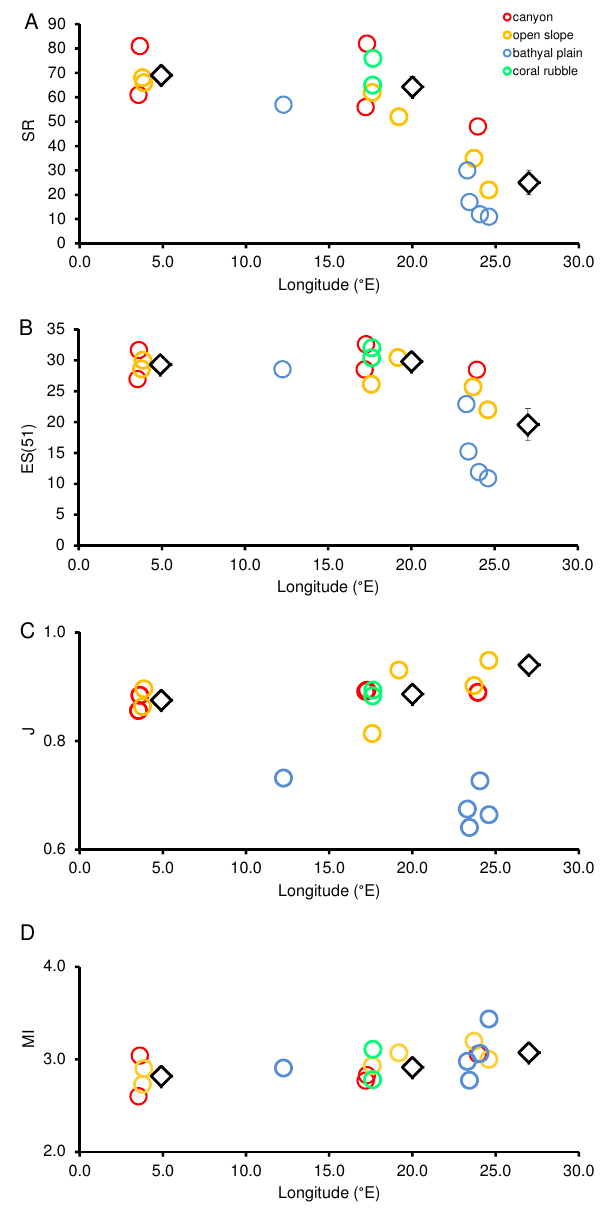
Fig. 4. α diversity in the different deep Mediterranean Sea regions: (A) Nematode SR; (B) ES(51); (C) species evenness J (the Pielou index,); (D) maturity index. Black diamonds, mean data ( ± SE) for the individual regions investigated: the north-western (ca. 5 ◦ lon- gitude), central (ca. 20 ◦ longitude) and eastern (ca. 27 ◦ longitude) Mediterranean